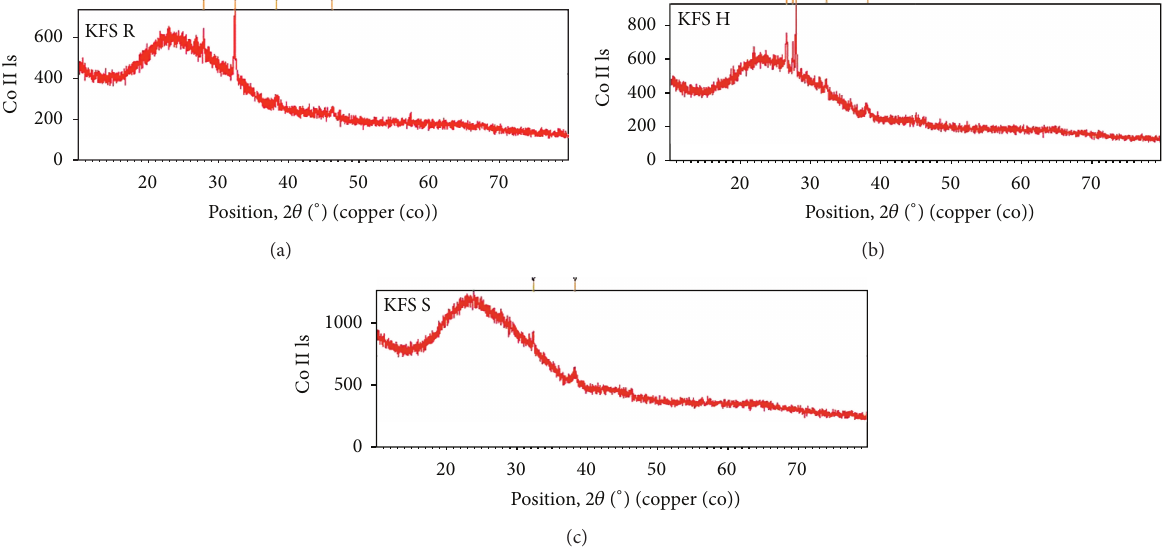
Figure 3: XRD spectra of synthesized silver nanoparticles using KFS extract under room temperature (a), higher temperature (b), and sonication